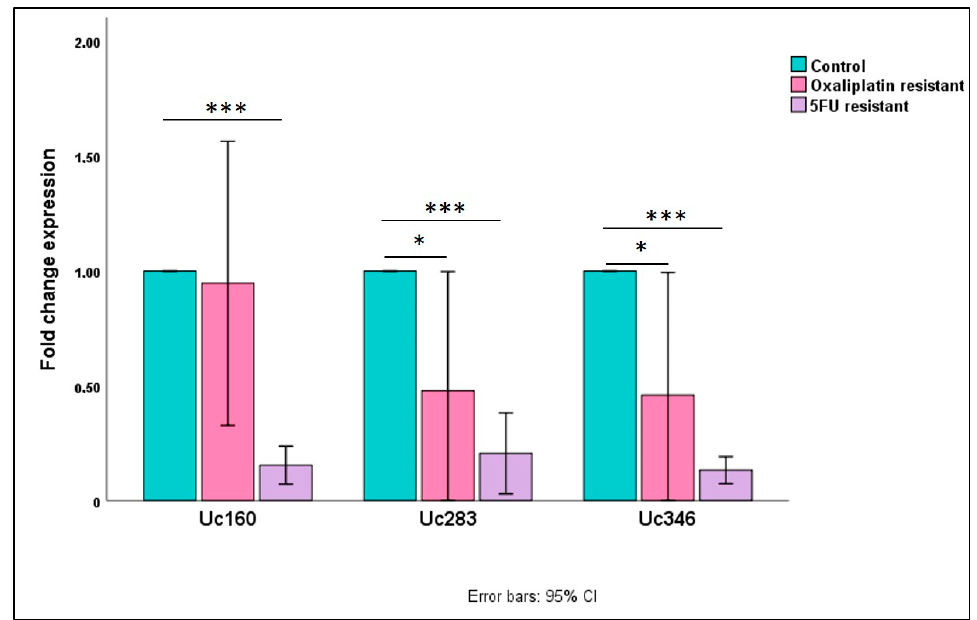
Figure 6. Fold change expression levels of Uc160, Uc283, and Uc346 in oxaliplatin and 5-fluorouracil (5-FU) resistant HT-29 cells compared to untreated cells (* p < 0.05, *** p < 0.0001).